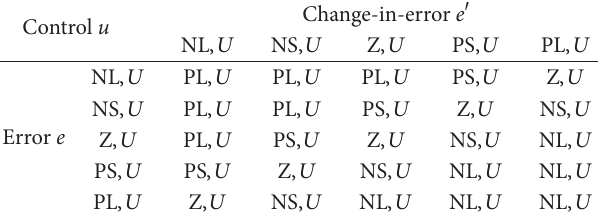
Figure 3: Membership functions of input variables. Table 1: Knowledge of the expert.